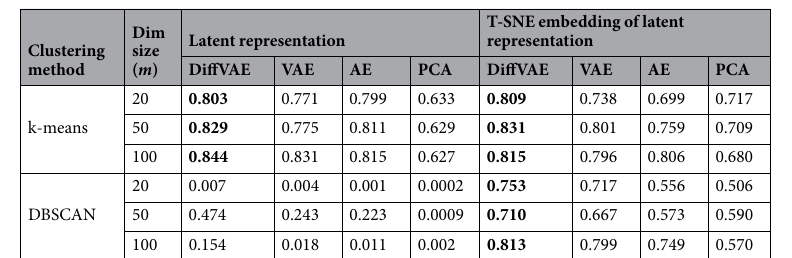
Clustering method